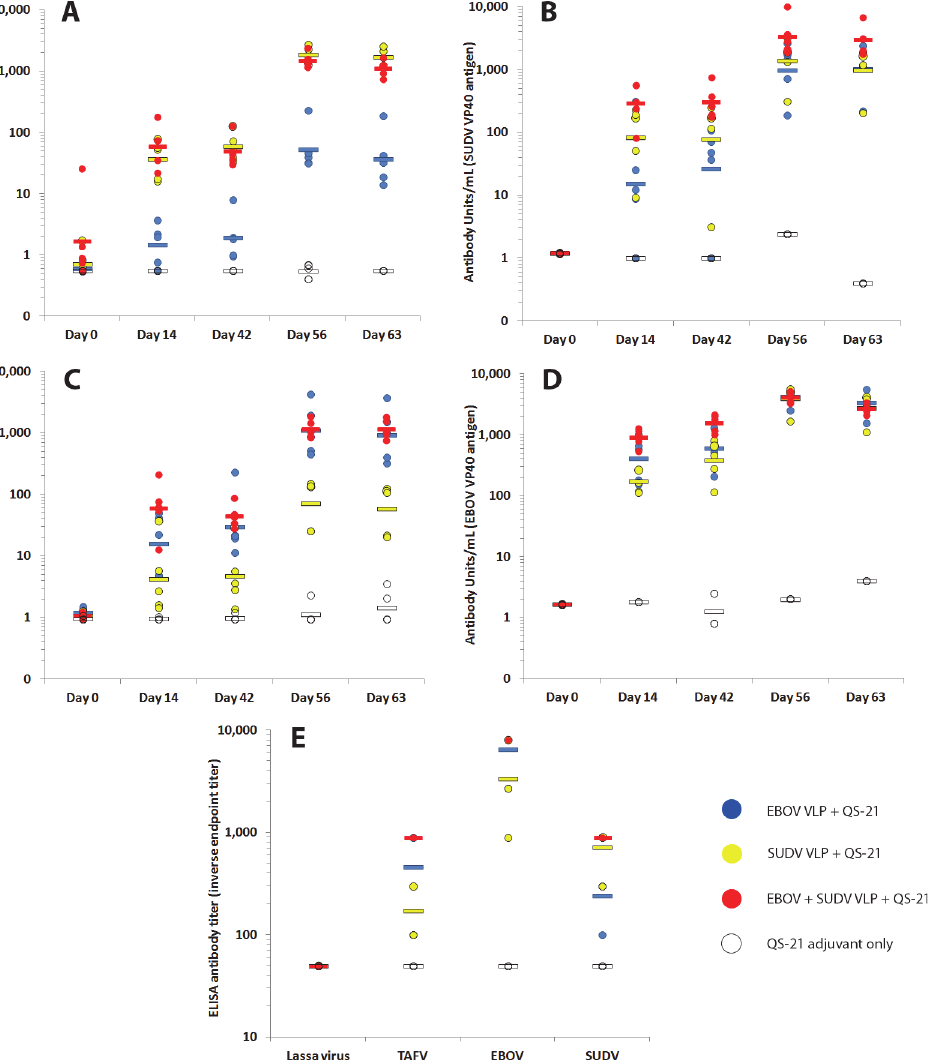
Fig 2. Humoral responses of VLP-vaccinated macaques. The data are shown as individual animal responses (circles) or as the mean antibody units for each group (lines) at each time point the samples were drawn. (A-D) Serum titers of VLP-vaccinated macaques were measured using the purified (A) SUDV GPdTM, (B) SUDV VP40, (C) EBOV GPdTM or (D) EBOV VP40 proteins using an IgG detection ELISA. (E) Antibody response to live virus in VLP- vaccinated animals prior to challenge. An ELISA was performed using live virus (EBOV, SUDV, TAFV, and Lassa virus) as the coating antigen. The data in Panels A-D represent empirically defined EC 50 values as described in Materials and Methods and data in Panel E are expressed as the means of the endpoint dilution (endpoint defined as inverse of last dilution with an OD >